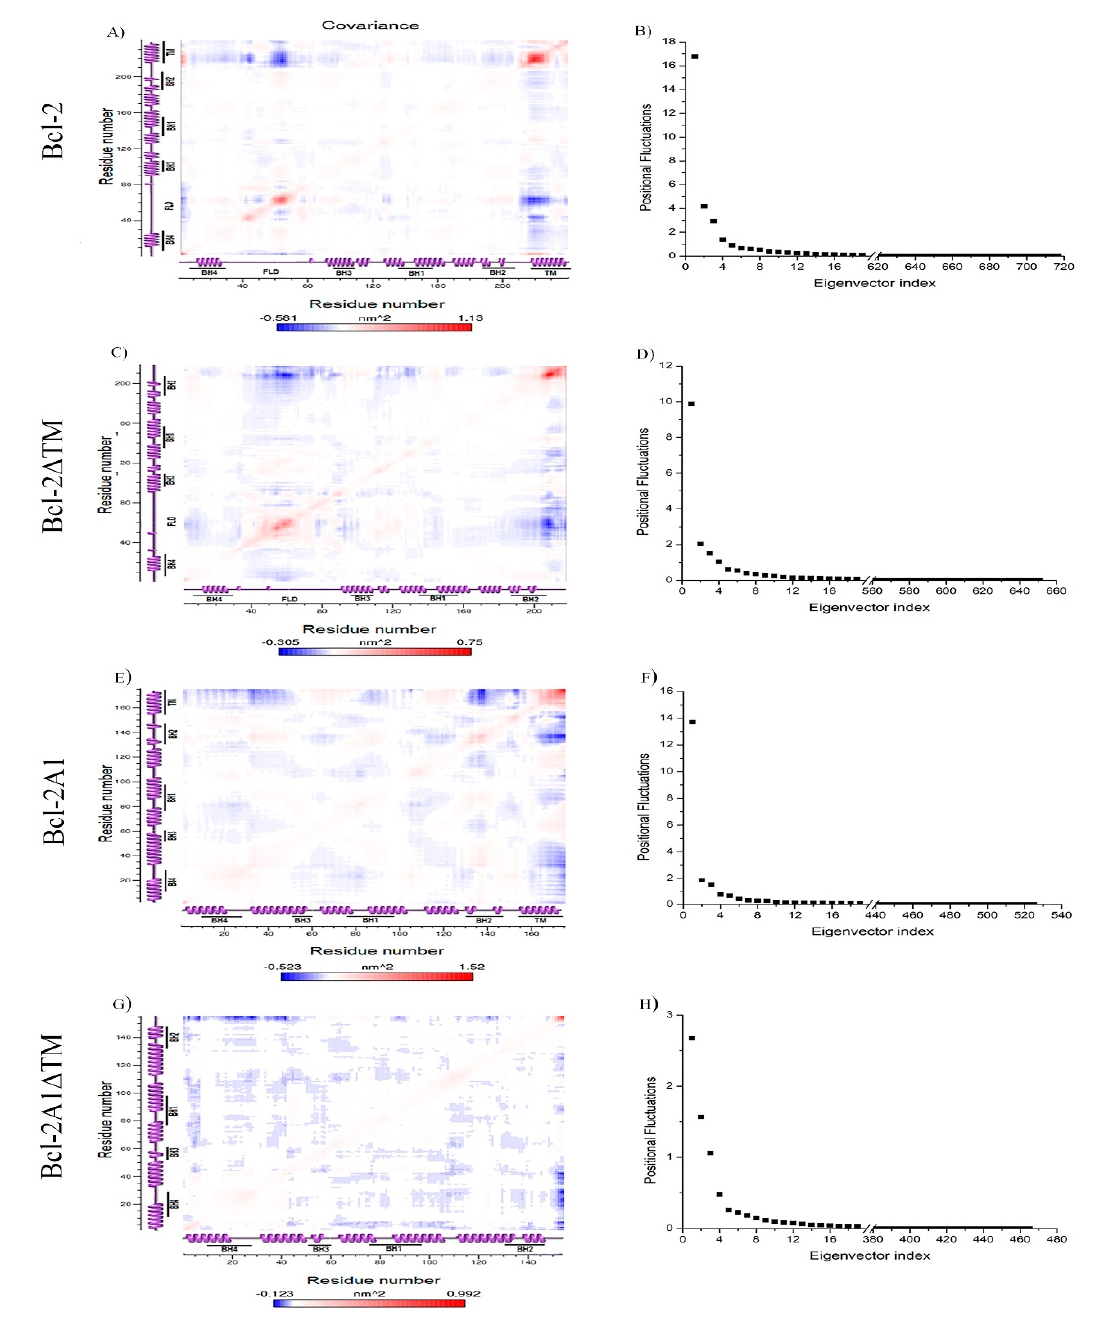
Figure 6. The covariance matrices ( A , C , E and G ) shows correlated (red) and anti-correlated (blue) motions between atoms. The color intensity indicates the amplitude of the RMS fluctuations (see the color bar). The corresponding eigenvalues fluctuations are shown in plots ( B , D , F and H ) in decreasing order of magnitude as obtained from the respective C- α coordinate covariance matrix.